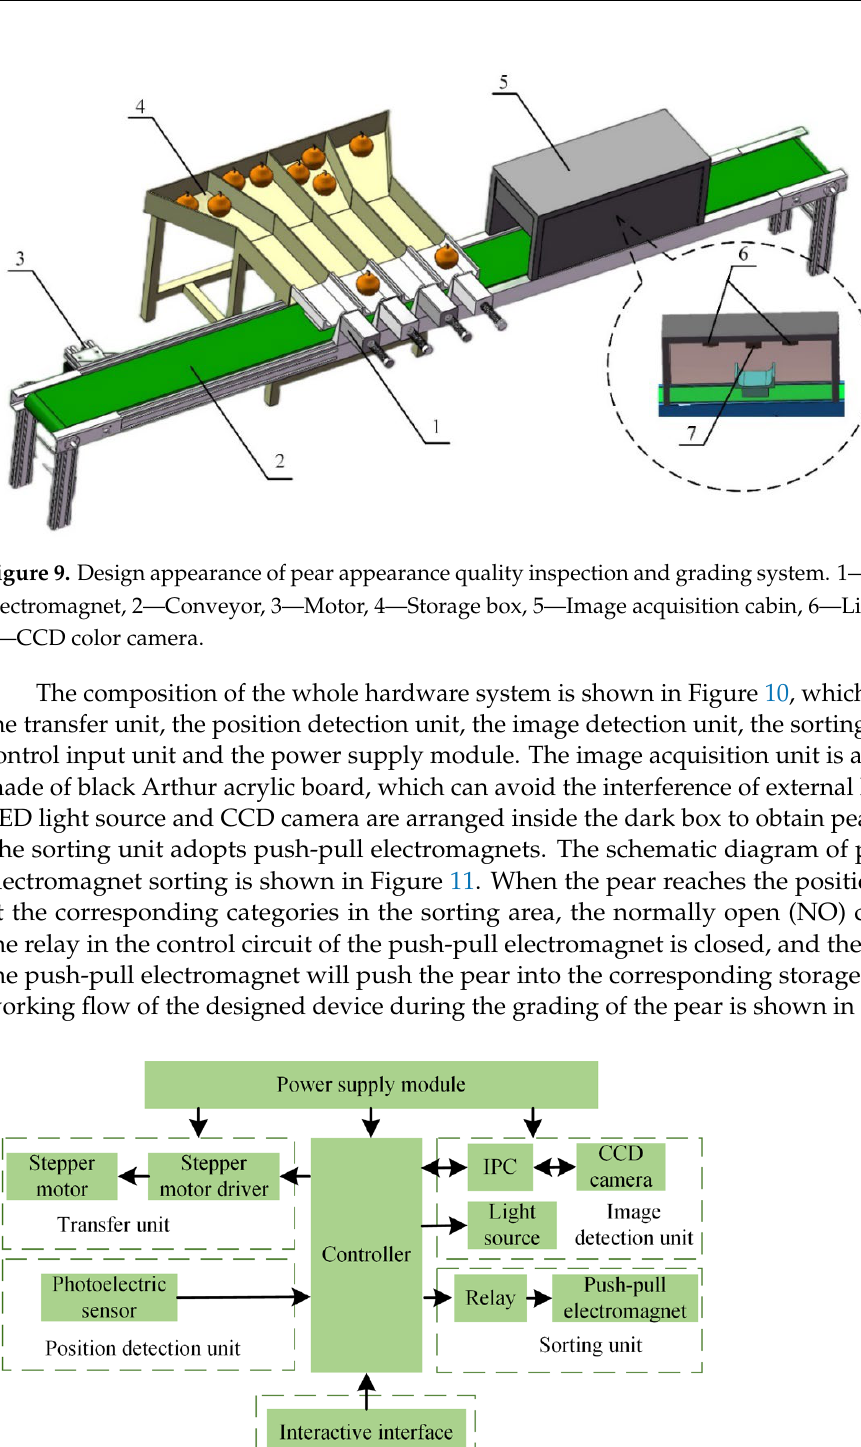
Figure 11. Schematic diagram of push-pull electromagnet sorting control. Figure 12. System work flow chart.